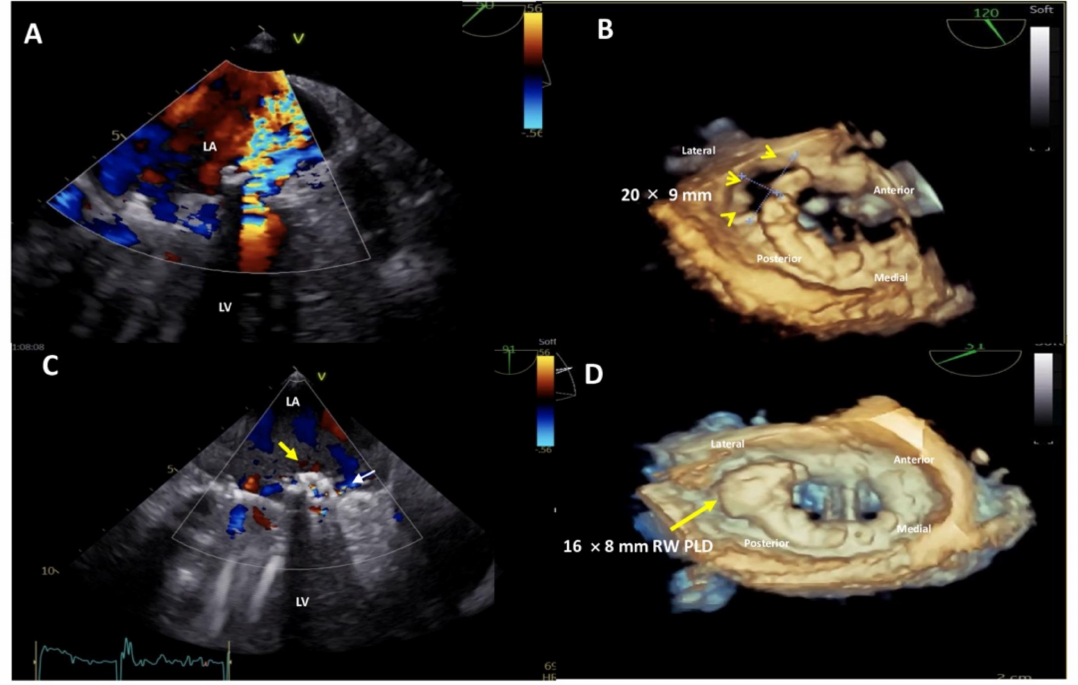
Figure 6. Upper panel: baseline 2D Transesophageal Echocardiogram (TEE) color Doppler showing a severe paravalvular leak (PVL) regurgitant jet into the left atrium ( A ) and 3D TEE showing a huge, 20 × 9 mm in diameter, crescent-shaped, antero-laterally located (7–10 o’clock) mitral PVL after bileaflet mechanical valve replacement ( B ). Lower panel: post-procedure 2D TEE color Doppler showing the correct position of the device ( C , yellow arrow) with a trace-mild residual regurgitant jet ( C , small white arrow) and 3D TEE confirming the stable position of the 16 × 8 mm-rectangular waist PLD (yellow arrow), without impingement on the mechanical prosthetic mitral valve ( D ). LA, left atrium; LV, left ventricle; PLD, Occlutech Paravalvular Leak Device; RW, rectangular